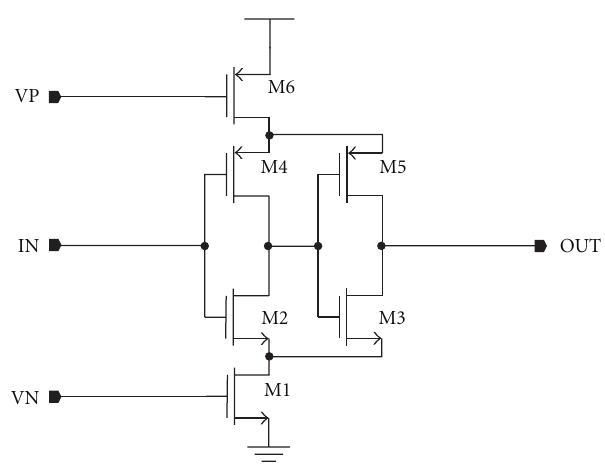
Figure 14: Circuit diagram of delay cell.